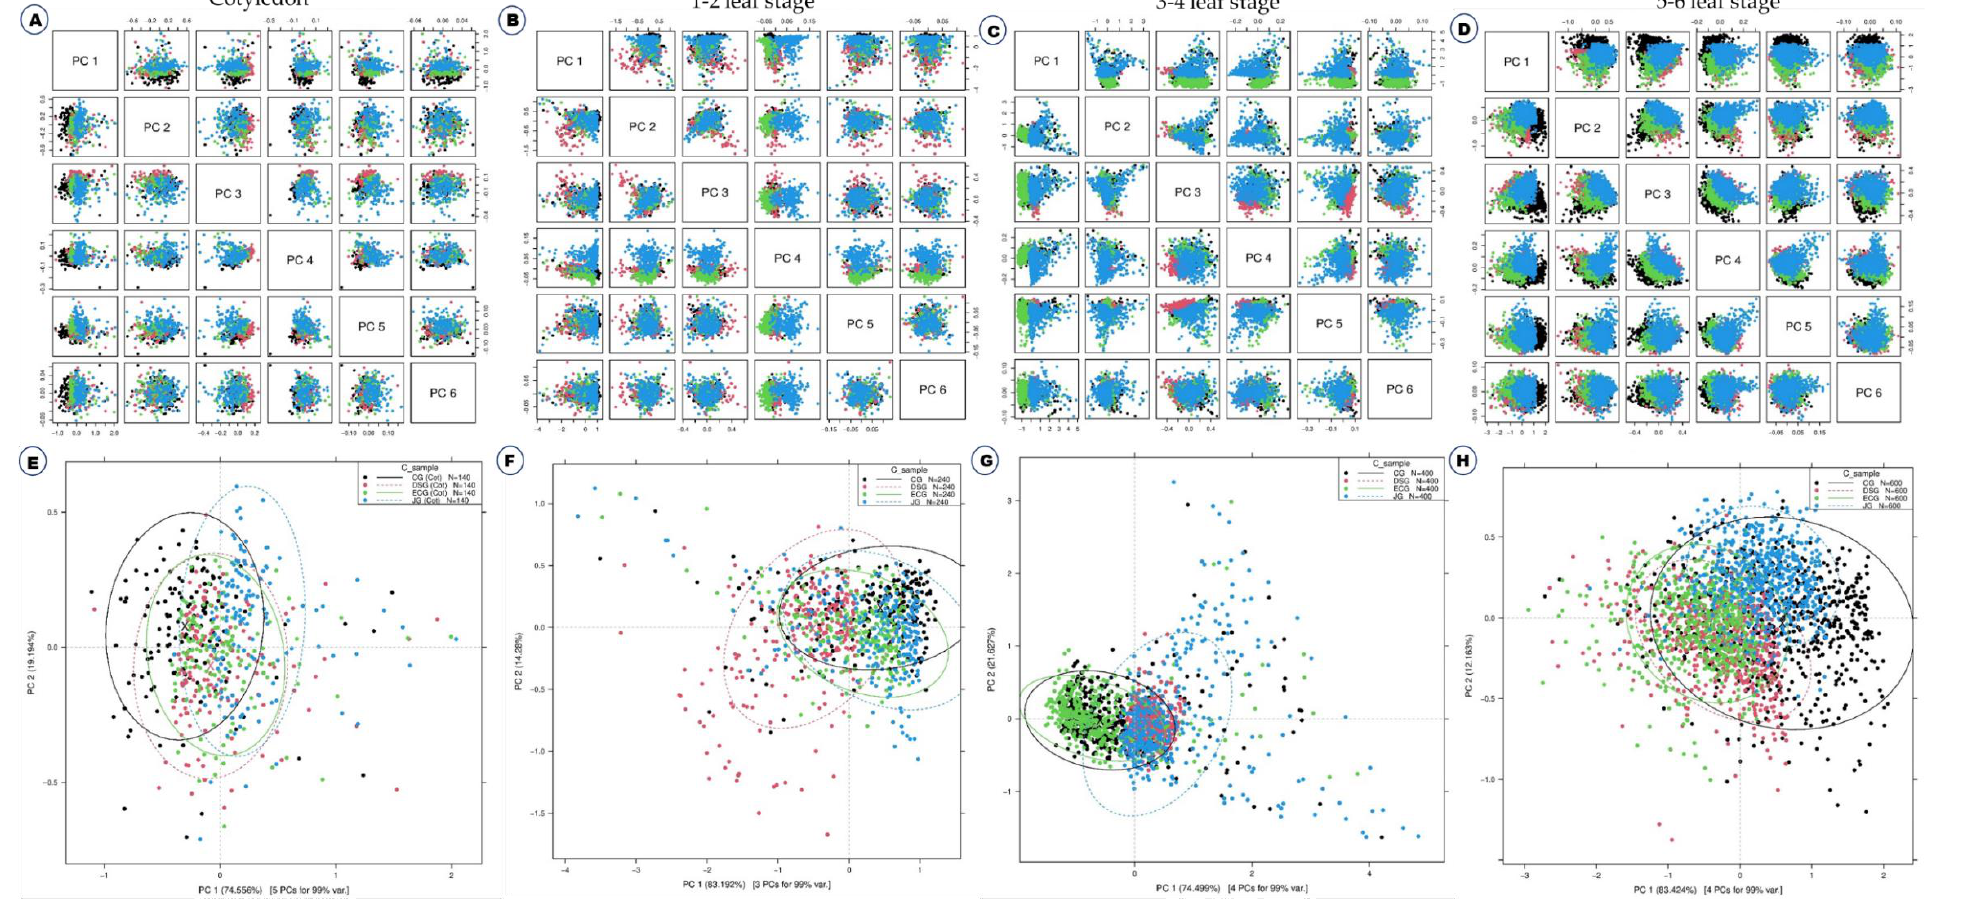
Figure 2. Principal component analyses based on the Vis-NIR spectra of four different growth stages of four Brassica juncea varieties. Raw spectra have been used. ( A – D ) Paired blot; ( E – H ) axes are the first and second principal components.